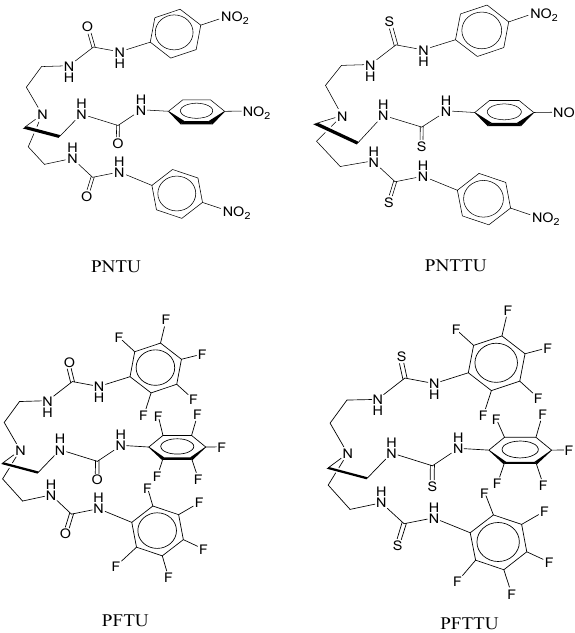
Figure 1. Chemical structures of acyclic receptors: PNTU (Para Nitro Tripodal Urea), PFTU (Penta Fluoro Tripodal Urea), PNTTU (Para Nitro Tripodal Thio-Urea), and PFTTU (Penta Fluoro Tripodal